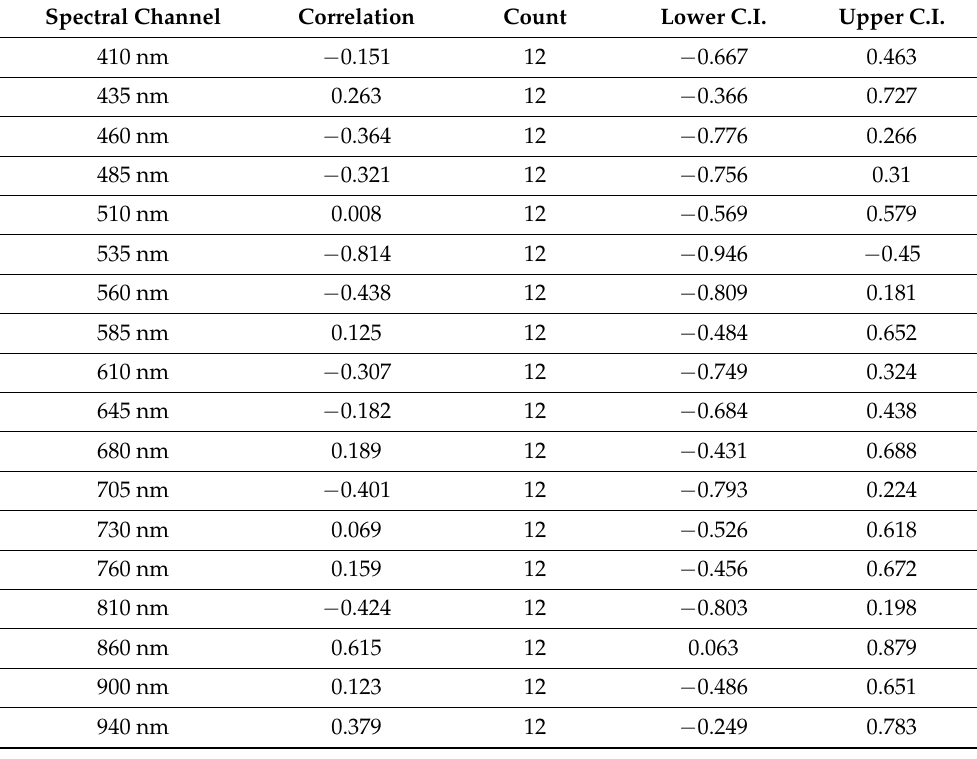
Table A1. The average spectral intensity for each channel per day according to the combined data of Tank L and Tank S and their correlation with the phosphorus concentrations.